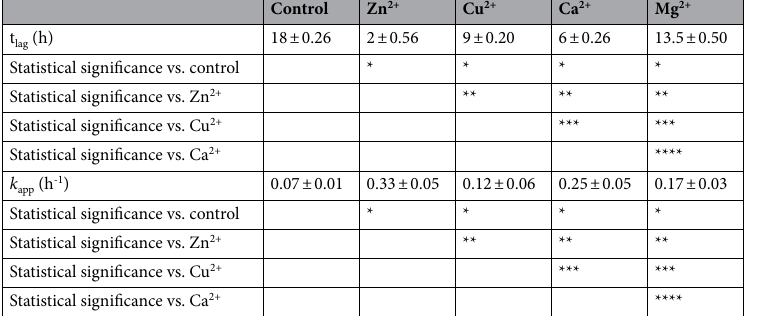
Table 1. Kinetic parameters of α-Syn fibril formation in presence and absence of each metal ion. The parameters were calculated based on kinetic studies displayed in Fig. 1 using Eq. (1). * p < 0.05 significant difference compared to the control group. ** p < 0.05 significant difference compared to the Zn 2+ group.